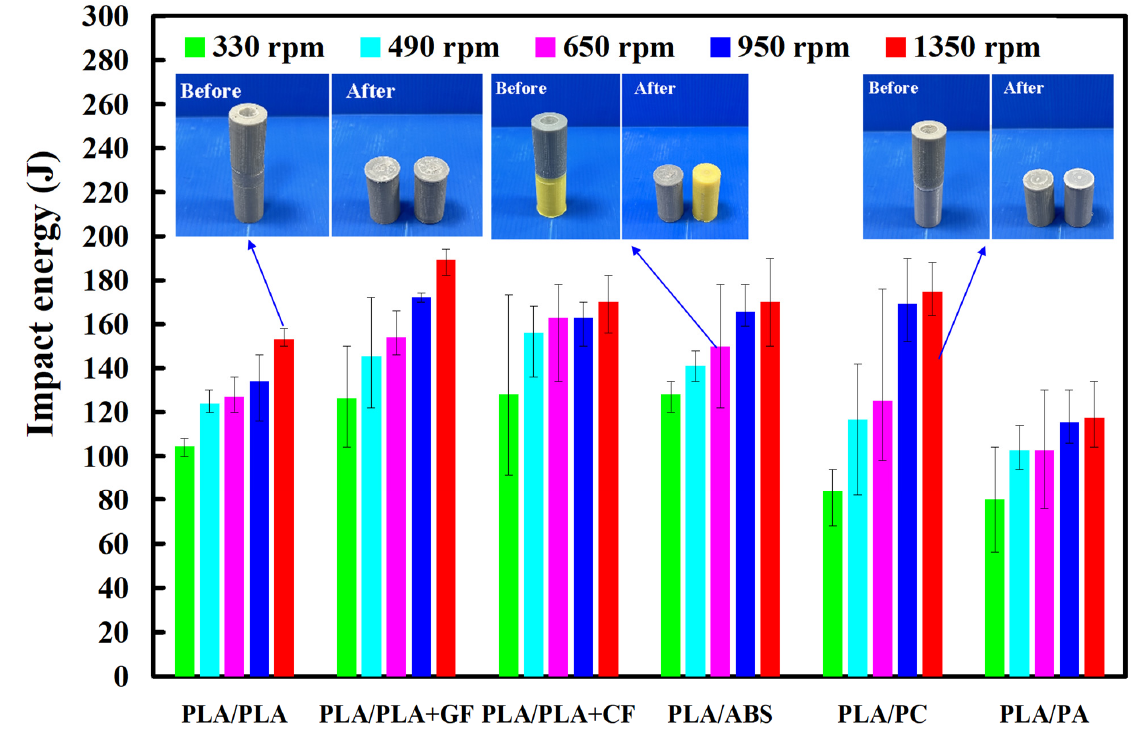
Figure 15. Impact energy of dissimilar polymer rods welded at five different rotational speeds.